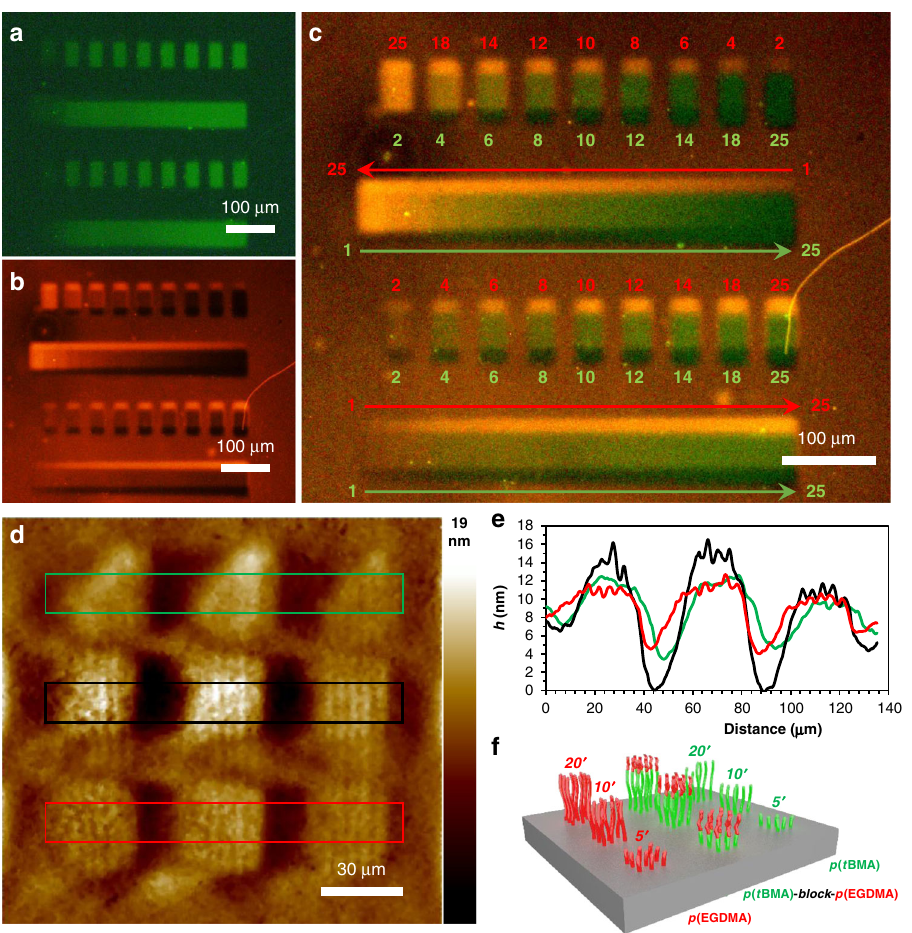
Fig. 4 Block copolymer arrays. a Fluorescence microscopy image ( λ ex = 530 – 550 nm, barrier fi lter λ em = 575 nm) of a p ( t BMA-FMA) (300:1) pattern composed of four rows printed at 1 – 25 minutes (left to right). b Fluorescence microscopy image ( λ ex = 530 – 550 nm, barrier fi lter λ em = 575 nm) of the same area as a showing a p (EGDMA-RMA) (6000:1) pattern composed of four rows printed at 1 – 25 min from right to left (top rows) and left to right (bottom rows). c Composite of a and b . d AFM height image of an array composed of p ( t BMA) brush features (triangles and middle row) printed at 5, 10, and 20 min t from right to left. Bottom row is composed of p (EGMA) brushes which were also printed over the p ( t BMA) on middle row at 5, 10, and 20 min from right to left. e Average height pro fi les of bands marked by colored squares in d .